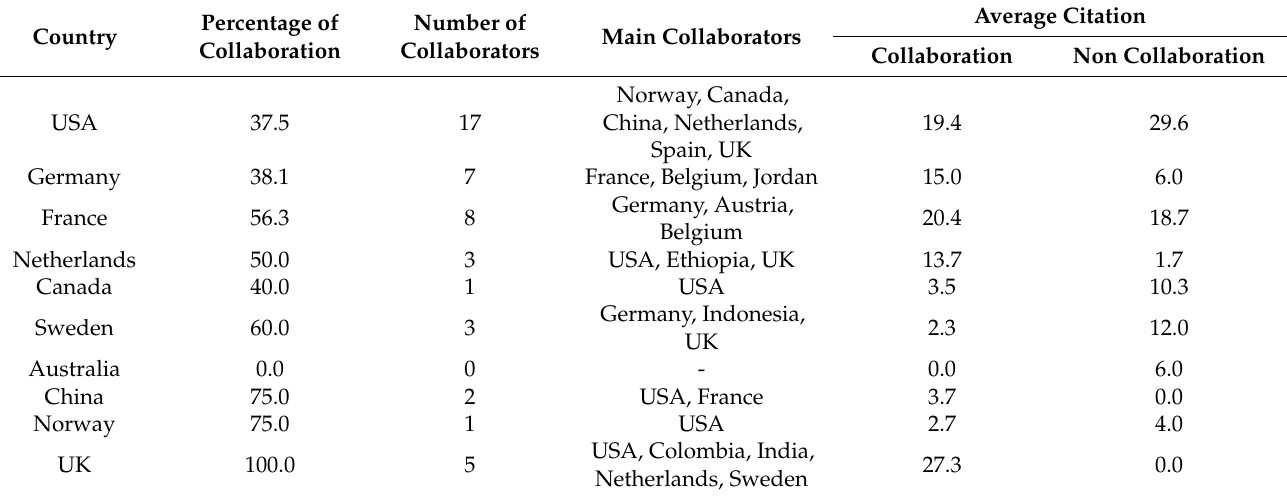
Average Citation